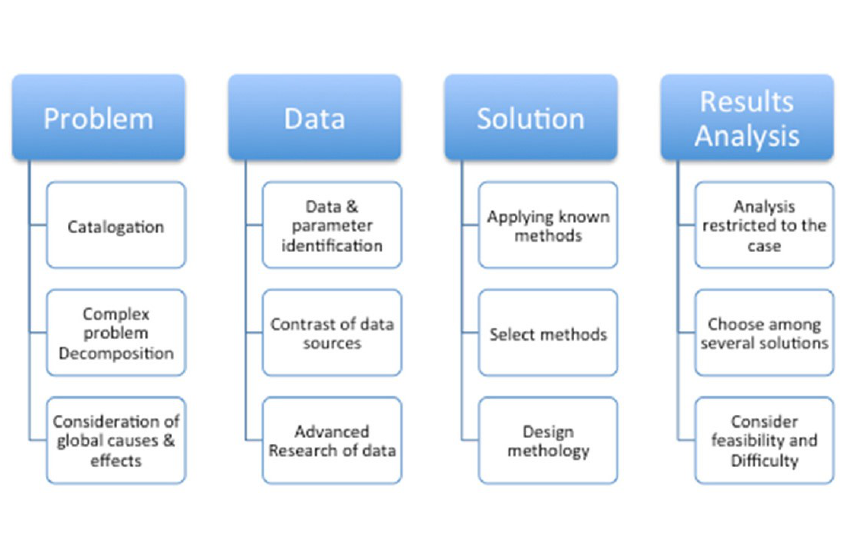
Figure 4. Dimensions by levels of CT-3 at UPV